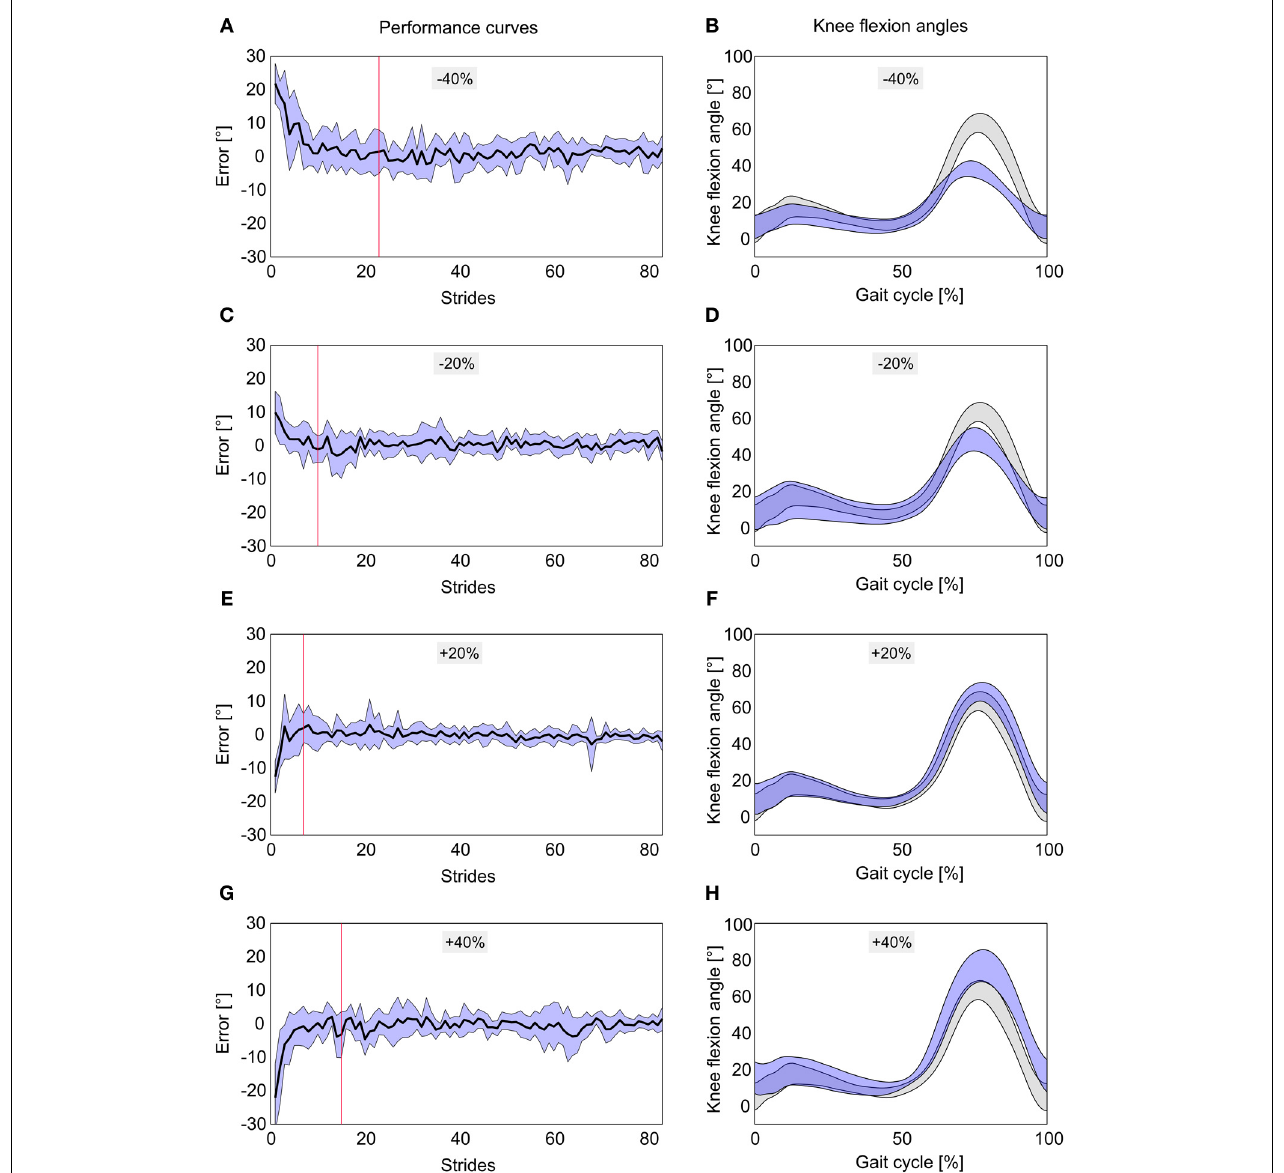
FIGURE 4 | Performance curves and mean knee flexion angles to the movement tasks − 40% (A,B), − 20% (C,D), + 20% (E,F), and + 40% (G,H) of normal knee flexion angles. Performance curves display 83 steps during feedback training averaged over 9 non-impaired individuals ± SD (blue area).